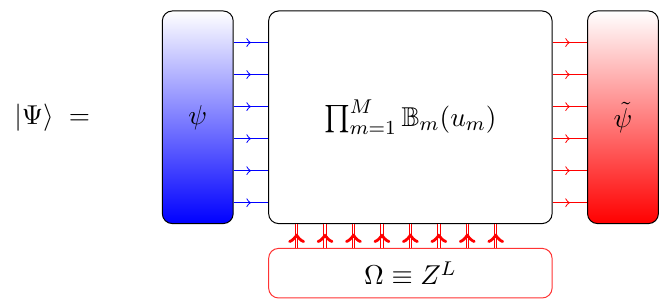
Figure 11. The so(6) Bethe